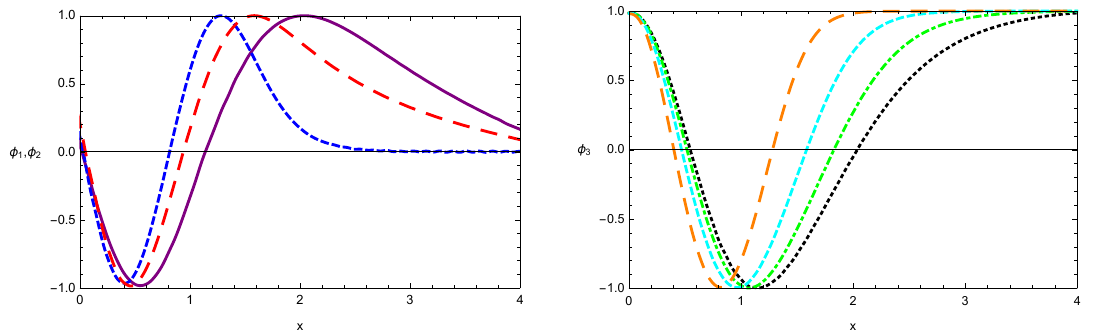
Figure 2 . Pro(cid:12)les of the (cid:12)eld components of the Q = 1 Hop(cid:12)ons in the model (2.1) with potential V = m 2 (cid:30) 2 and c 2 = 1, c 4 = 1. Left: (cid:12)eld components (cid:30) 1 ( x; 0 ; 0) at m = 0 (purple solid), (cid:30) 1 ( x; 0 ; 0) 1 (blue dashed) and (cid:30) 2 (0 ; y; 0) (red long-dashed) at m = 4. Right: (cid:12)eld component (cid:30) 3 ( x; 0 ; 0) at m = 0 (black dotted), m = 1 (green dotted-dashed), m = 2 (cyan dashed) and m = 4 (orange